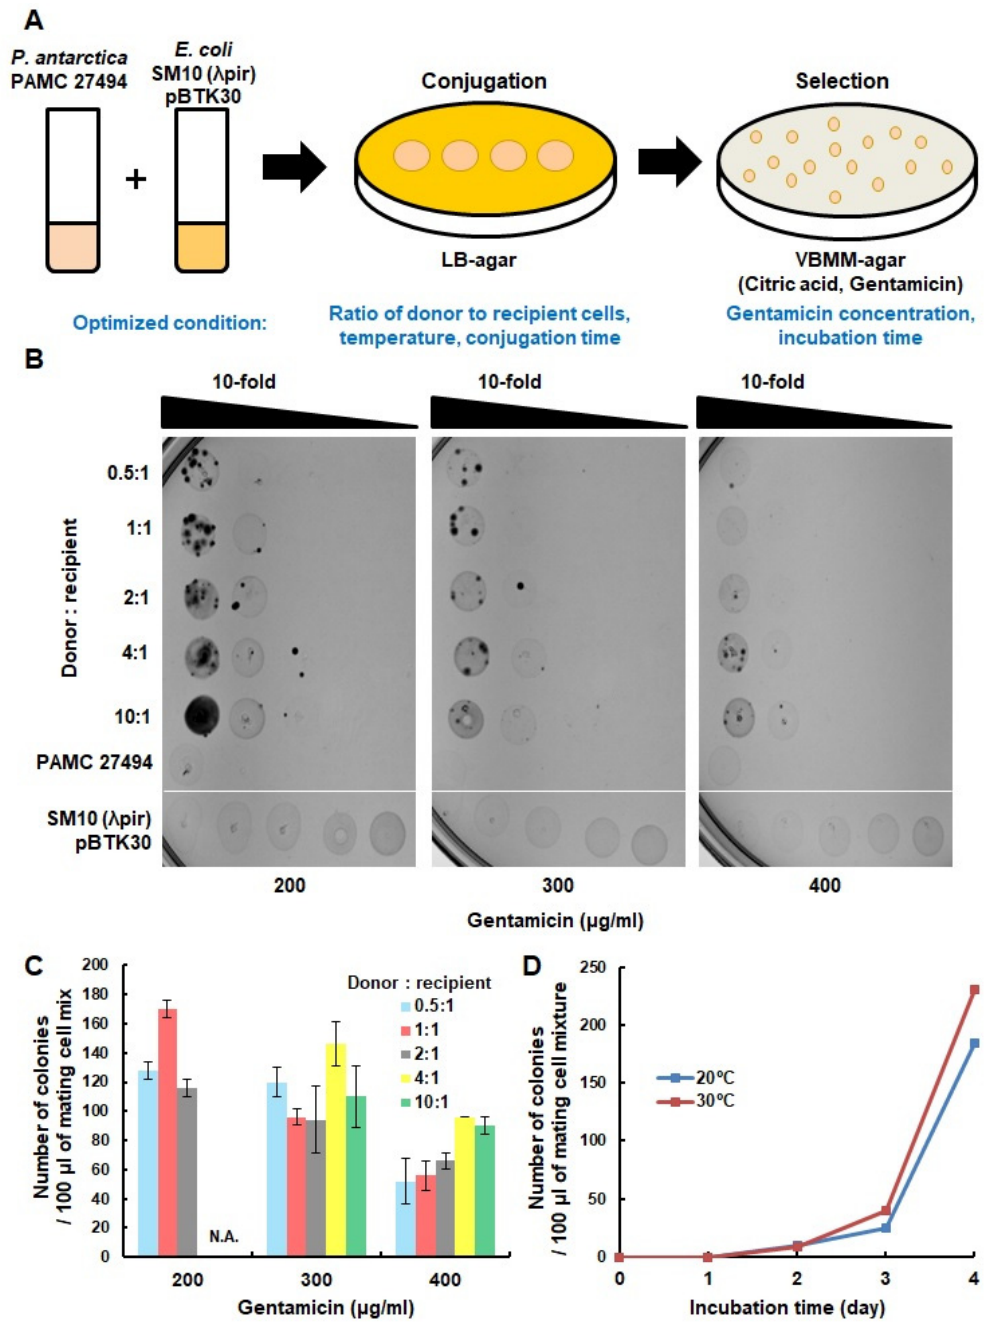
Figure 1. Optimization of transposon insertion methods in the P. antarctica PAMC 27494